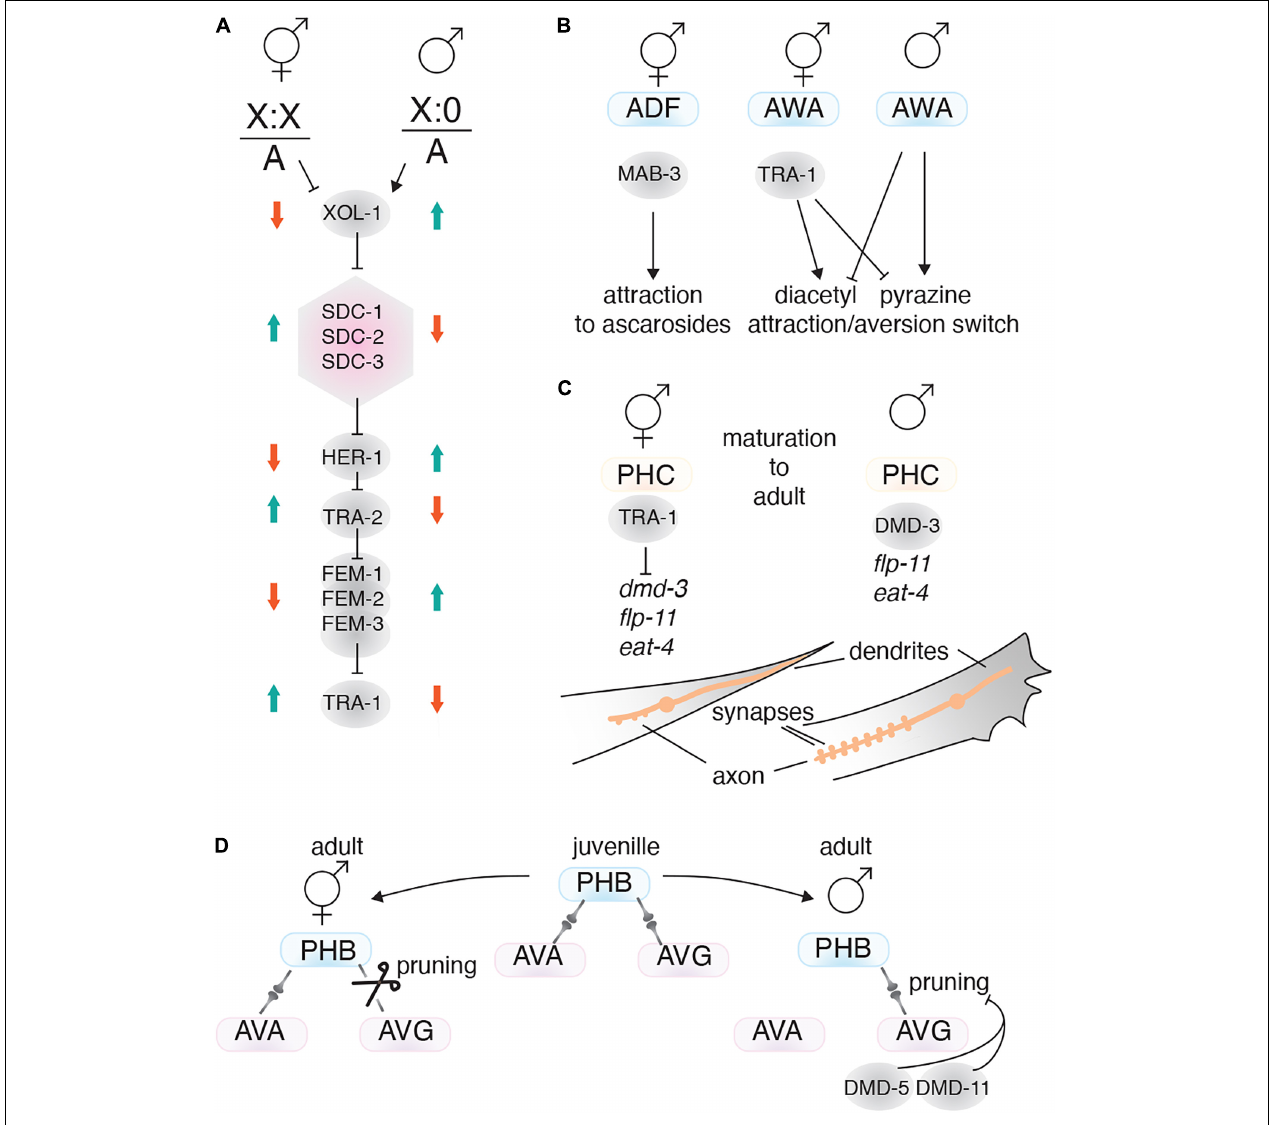
FIGURE 6 | Transcription factors involved in sex-specific behavior. (A) The C. elegans sex determination pathway. The X chromosome/autosome ratio (X:0) controls the pathway by regulating XOL-1. In males, high XOL-1 activity supresses the pathway, resulting in lower TRA-1 expression. TRA-1 is the master regulator of the hermaphrodite phenotype. The dosage compensation complex is shown as a pink hexagon. (B) TFs (gray circles) that drive sex-specific chemotaxis. (C) The TFs TRA-1 and DMD-3 regulate sex-specific PHC neuron characteristics. The PHC tail neurons exhibit sex-specific axo-dendritic length and synapse